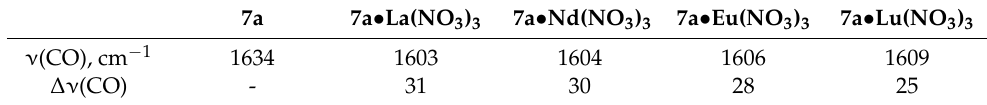
Table 3. Characteristic shifts of the C=O band in complexes.